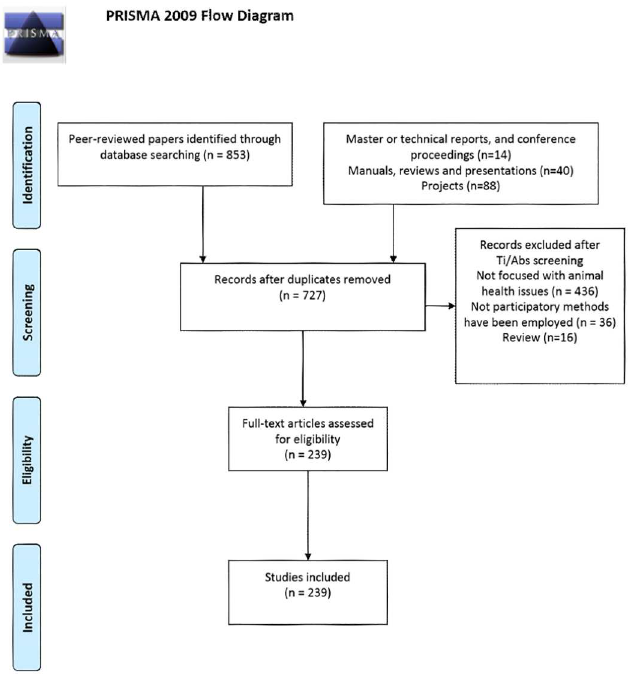
Fig 1. Flow diagram: search strategy